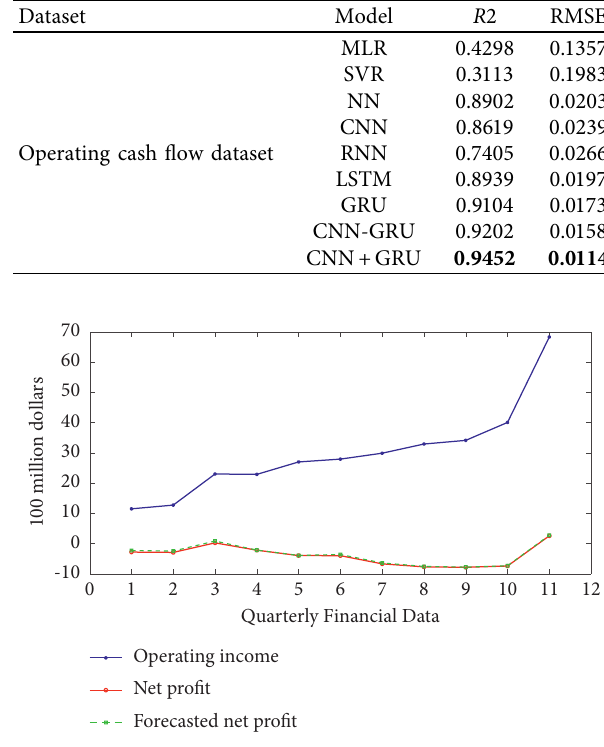
Figure 7: Financial real value and forecast of a new energy vehicle